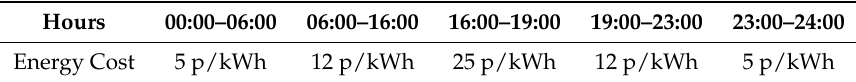
Table 1. Energy price during the